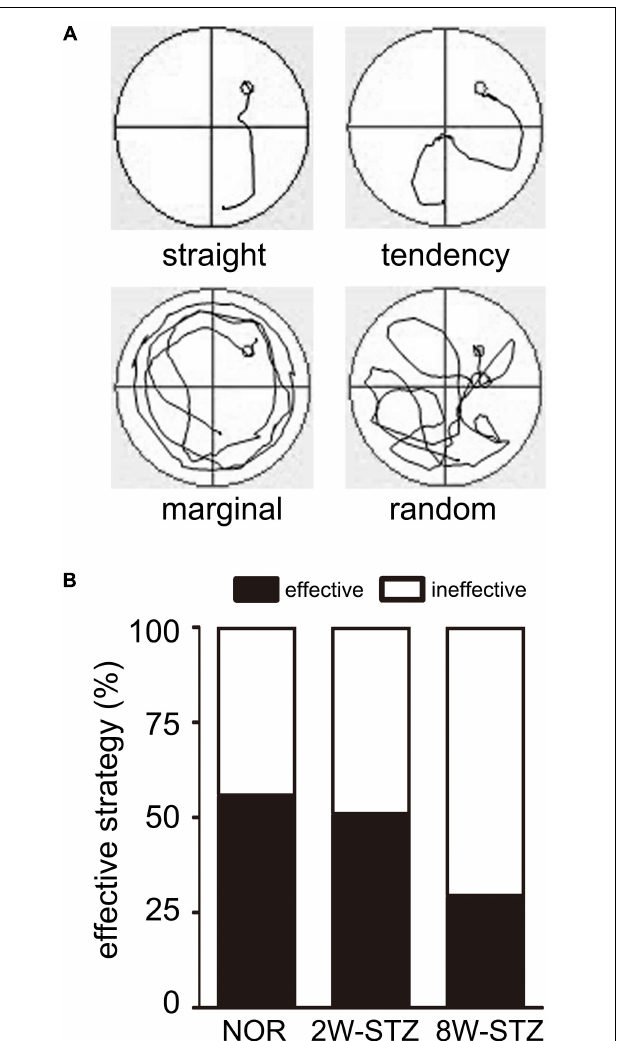
FIGURE 4 | The normal rats applied more effective ability compared to diabetic rats. (A) The swim paths for each trial were monitored by charge coupled device image detectors and divided into 4 types including straight, tendency, marginal and random by an investigator blinded to experimental groups. Different swim paths showed different search abilities in the experiment. Straight and tendency are considered as the effective ability, while marginal and random are considered as the ineffective ability. (B) Bar graphs showed the 8W-STZ rats preferred an ineffective ability compared with that of the normal rats and the 2W-STZ rats ( p < 0.01). n = 6–8 per group. NOR, normal rats; 2W-STZ, 2-week STZ; 8W-STZ, 8-week